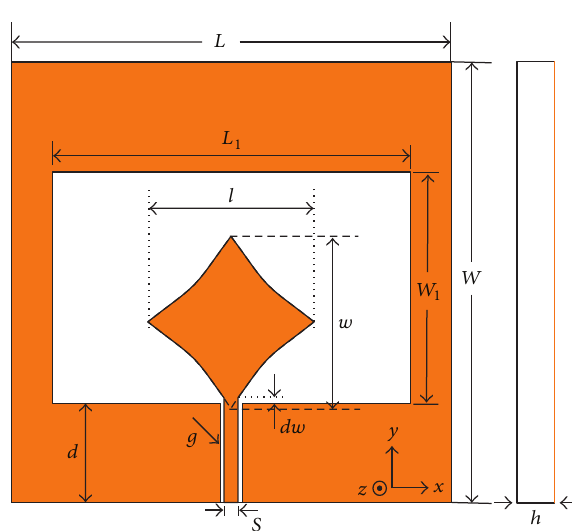
Figure 4: Geometry of the proposed antenna, with the blending coefficient 𝑡 = 1.3 .